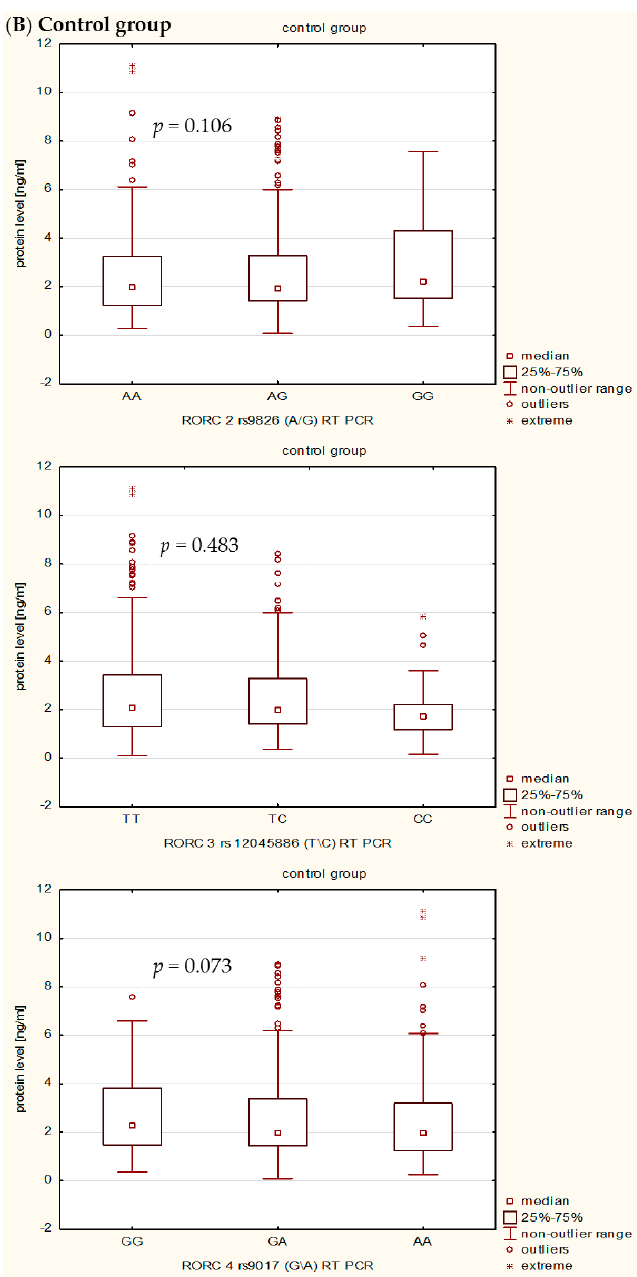
Figure 4. Variation in RORc expression levels in ( A ) RA patients and ( B ) control group in relation to RORc2 genotypes: ( A ) rs9826 A/G, p = 0.589; rs12045886 T/C, p = 0.207; and rs9017 G/A, p = 0.776; and ( B ) rs9826 A/G, p = 0.106; rs12045886 T/C, p = 0.483; and rs9017 G/A, p = 0.073. p , Kruskal–Wallis test; p < 0.05 was considered significant.